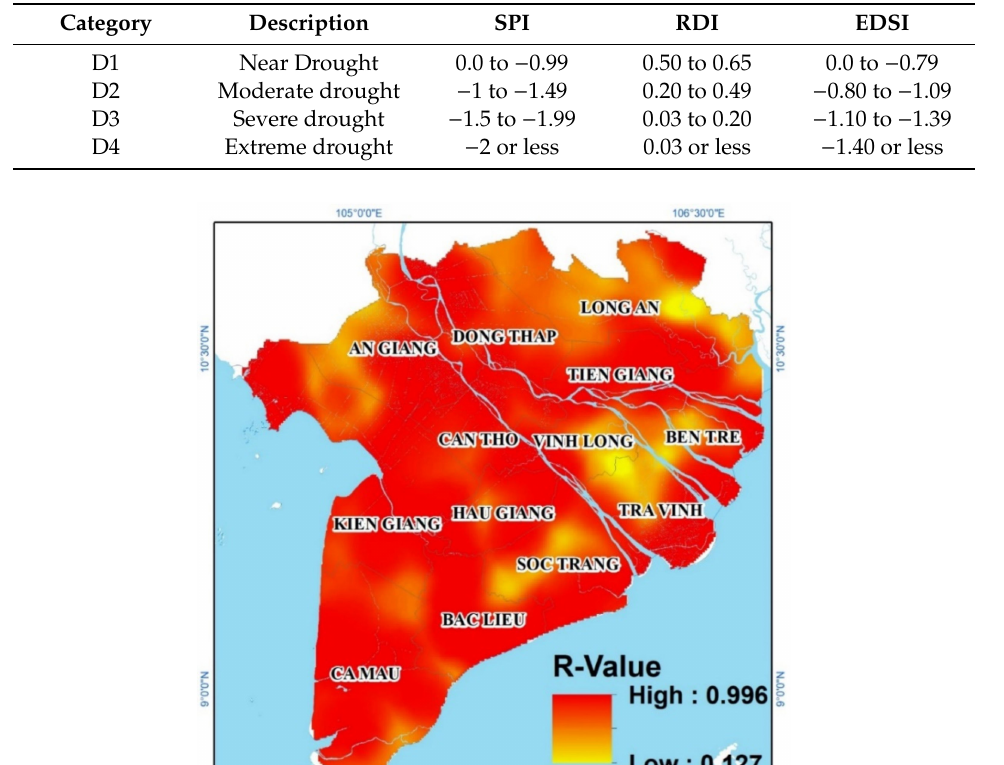
Table 3. The EDSI dynamic range and relative categories for dry conditions.